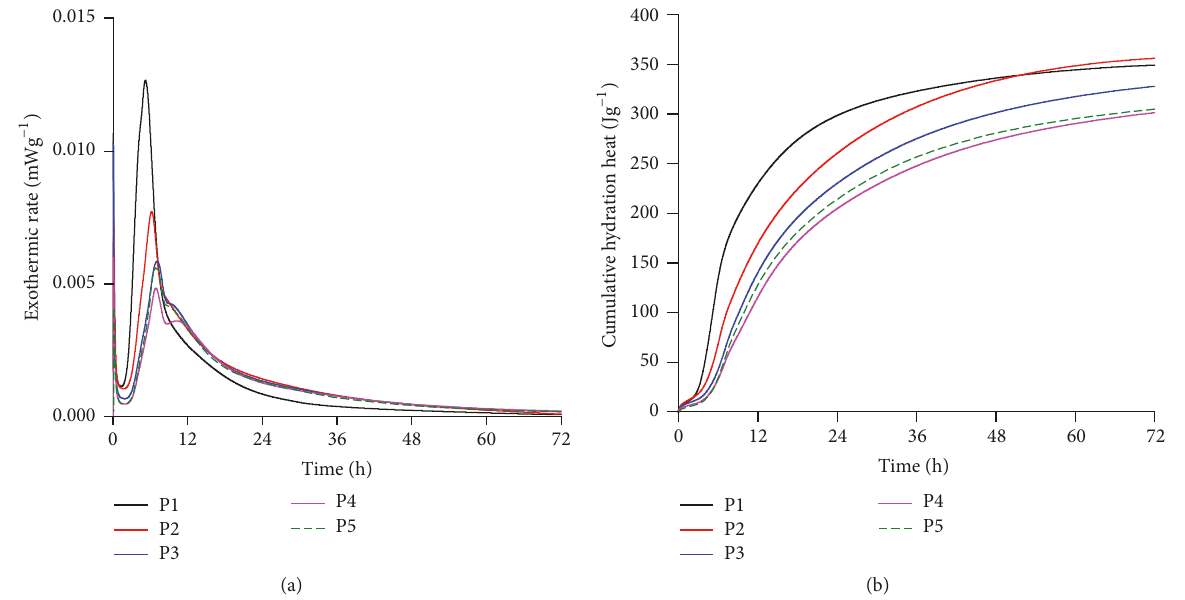
Figure 3: (a) Exothermic rate curves during the hydration of plain cement and composite binders at 45 ∘ C. (b) Cumulative heat curves during the hydration of plain cement and composite binders at 45 ∘